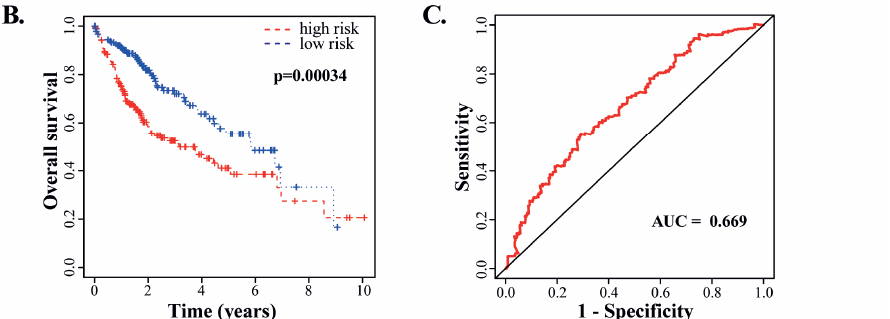
Figure 7. Analyses of the clinically prognostic values of PD-repressed genes regulating spindle midzone formation. ( A ) Kaplan–Meier plots of the correlation between each of the five genes regulating the spindle midzone and the overall survival rates of HCC patients in the TCGA-LIHC dataset. ( B ) The multivariate Cox’s regression analysis of the 5 DEGs regulating spindle midzone formation with the patients’ survival in the TCGA-LIHC dataset. According to the results of the Cox model, the patients were divided into low- and high-risk groups (185 and 184 patients, respectively), and Kaplan–Meier survival curves of the two groups are presented. The 5-year overall survival rates were determined as 38.4% (95% CI: 29.1%–50.8%) and 55.3% (95% CI: 44.7%–68.4%) for the high- and low-risk groups, respectively. ( C ) The receiver operating characteristic (ROC) curve to test the accuracy of the Cox model. The value of the area under the curve (AUC) was determined as 0.669, indicating a high accuracy of the Cox model analysis.